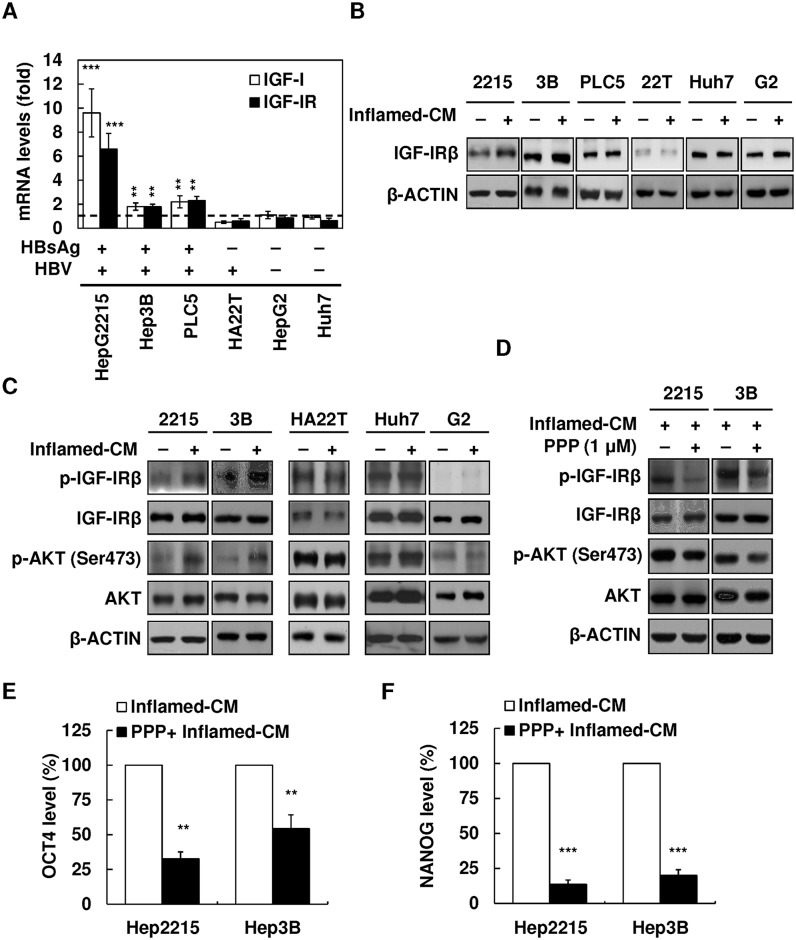
Upregulation of IGF-I and IGF-IR in HBV-HCC cell lines with inflamed-CM treatment.mRNA levels of IGF-I and IGF-IR in human HCC cell lines of HepG2.2.15, Hep3B, PLC5 (HBV+HBsAg+), HA22T (HBV+HBsAg−), HepG2, and Huh7 (HBV−HBsAg−) with inflamed-CM treatment for 7 days (by quantitative real-time RT-PCR). The dashed line indicates the gene expression in HCC cells without inflamed-CM treatment (multiple of expression = 1, control group). (B) IGF-IR levels in HCC cells with and without inflamed-CM treatment (by Western blotting). (C) Effect of inflamed-CM on the activation of IGF-IR/Akt signaling in HBV+HBsAg+ HepG2.2.15 and Hep3B is shown. (D) Effect of IGF-IR phosphorylation inhibitor PPP on inflamed-CM-induced IGF-IR/Akt signaling activation is shown. Effect of PPP (1 μM) on inflamed-CM-induced mRNA levels of OCT4
(E) and NANOG
(F) in HepG2.2.15 and Hep3B cells is shown. **P < .01, ***P < .001, by t-test.